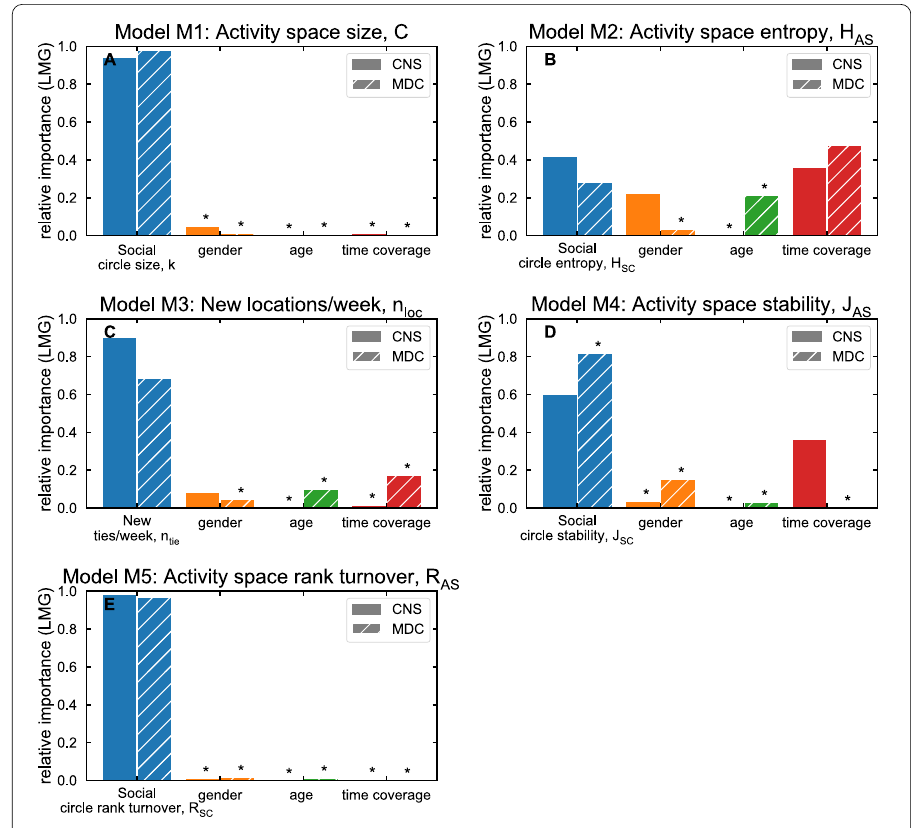
Figure 4 Relative importance of regressors. LMG of each regressor computed using the Lindeman, Merenda and Gold method [79] for models M1 ( A ), M2 ( B ), M3 ( C ), M4 ( D ) and M5 ( E ). Plain bars show results for the CNS dataset, dashed bars for the MDC dataset. Variables that are not significant in the regression model are marked with *